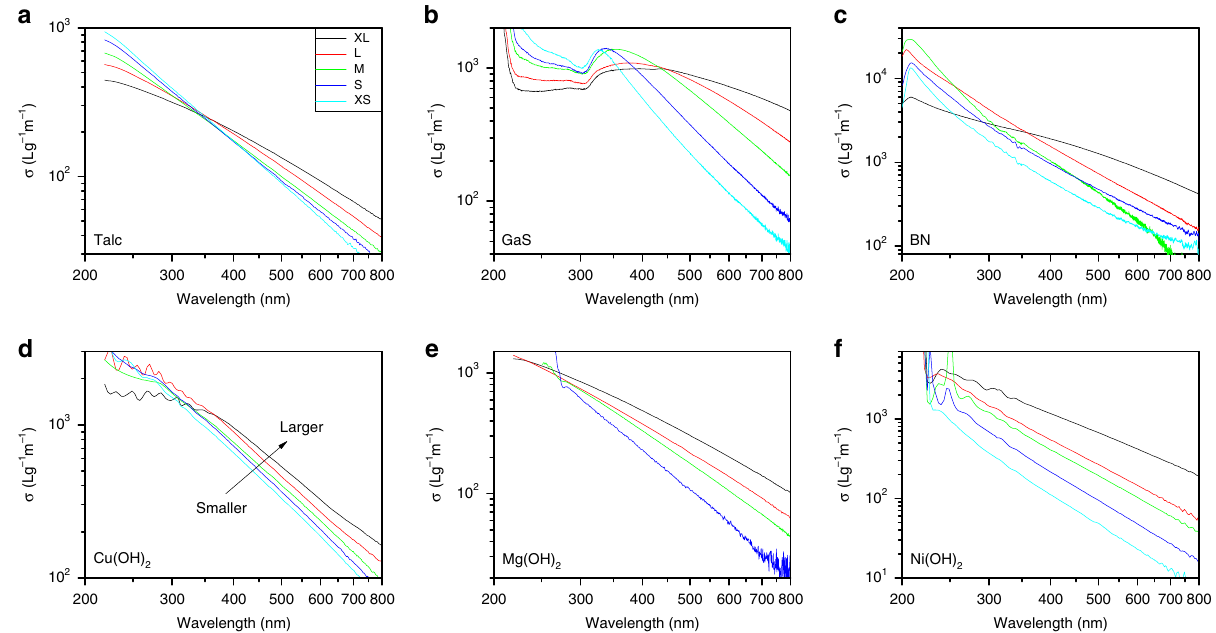
Fig. 5 Scattering coef fi cient ( σ ) spectra for size-selected fractions for each material. Each panel shows data for fi ve fractions, labelled XL, L, M, S, XS with nanosheet size decreasing from XL to XS (although for some materials, additional fractions were prepared). The colour scheme is the same in all